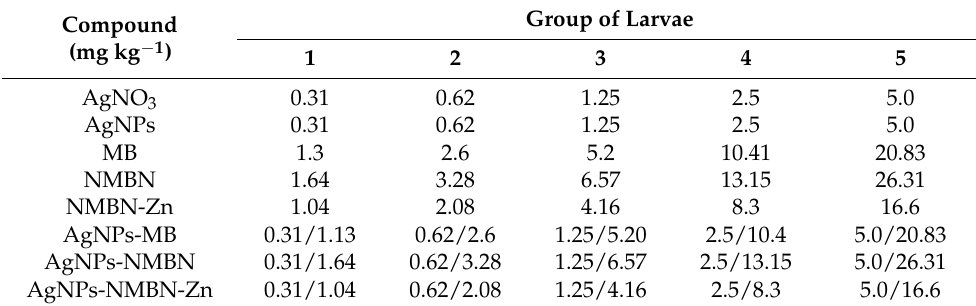
blue N; NMBN-Zn, new methylene blue N Zinc.